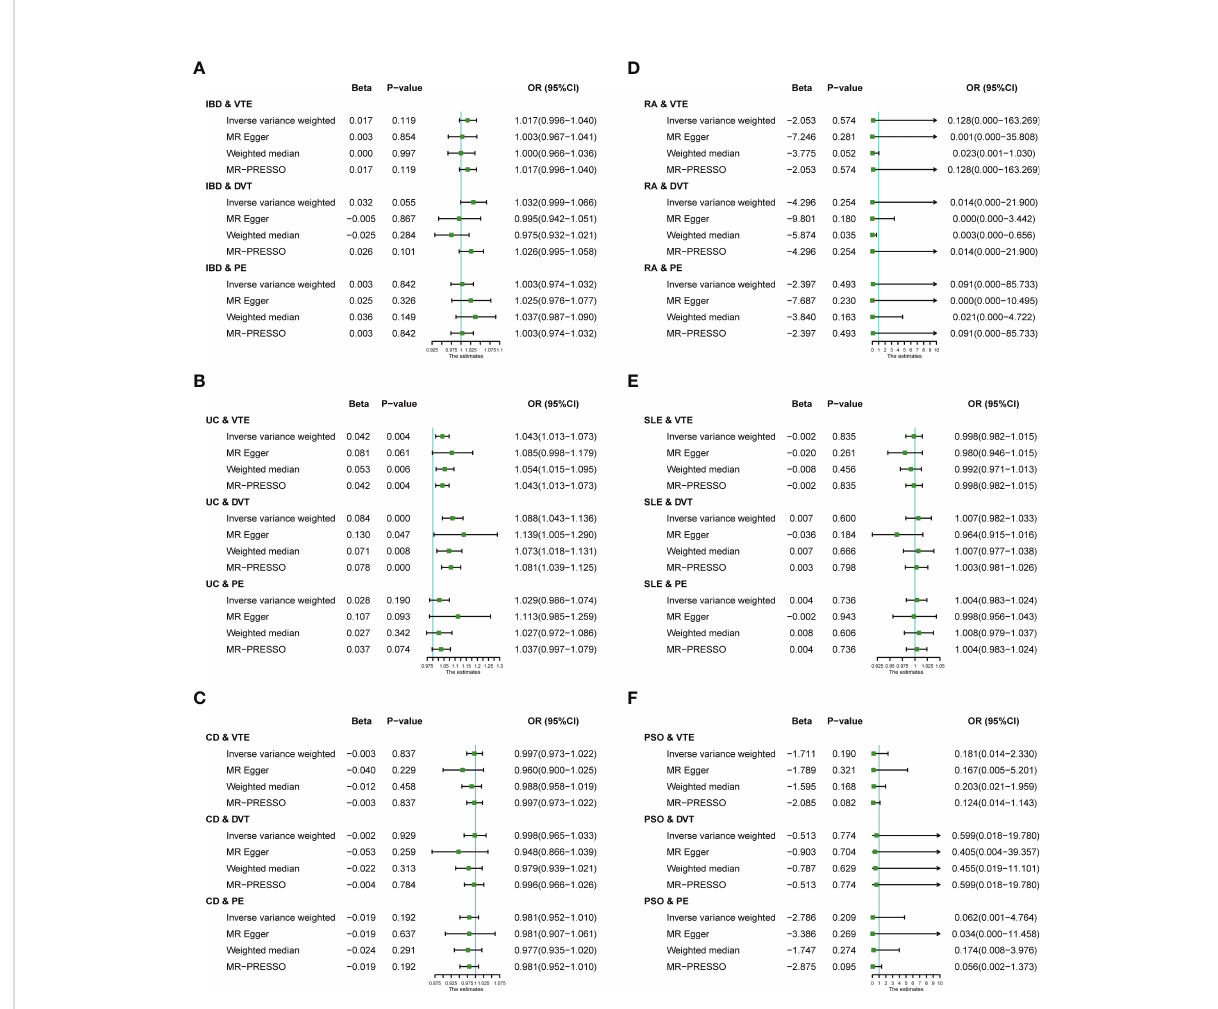
FIGURE 2 Estimates from Mendelian randomization analysis of IMIDs [ (A) IBD; (B) UC; (C) CD; (D) RA; (E) SLE; (F) PSO] and risk of VTE/DVT/PE. OR, Odd Ratio; IBD, in fl ammatory bowel disease; CD, Crohn ’ s disease; UC, ulcerative colitis; RA, rheumatoid arthritis; SLE, Systemic Lupus erythematosus; PSO, Psoriasis; VTE, Venous thromboembolism; DVT, deep vein thrombosis; PE, pulmonary embolism; CI, con fi dence